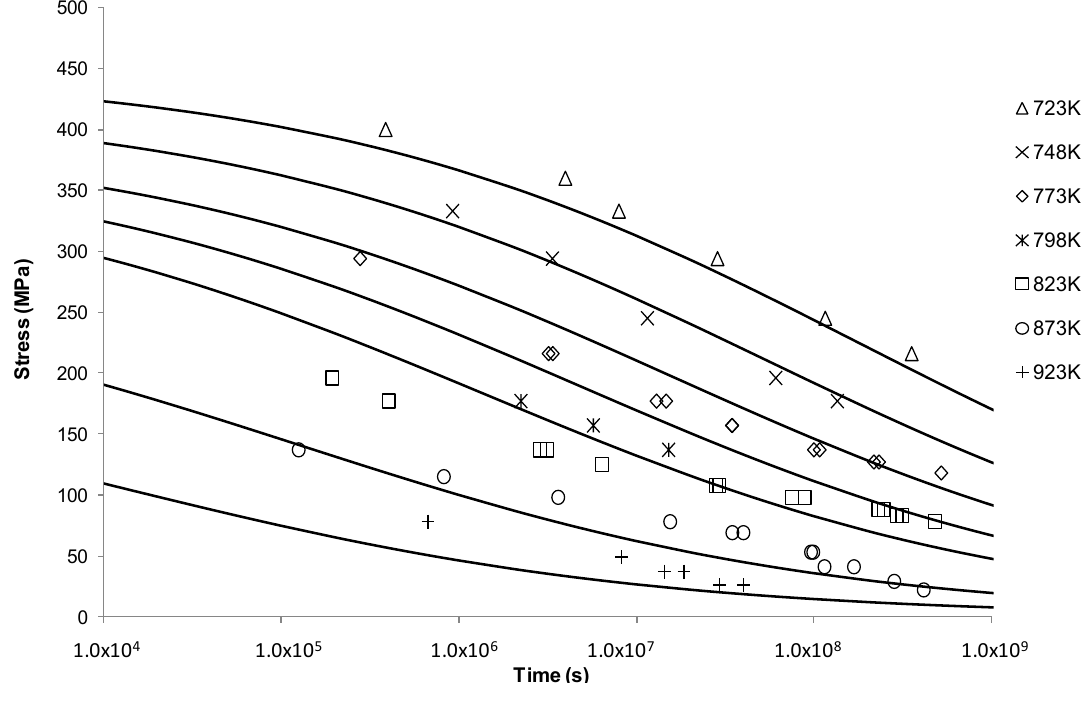
Figure 10. The Hyperbolic Tangent’s stress vs . time to fracture predictive curves using Grade 22 Steel creep